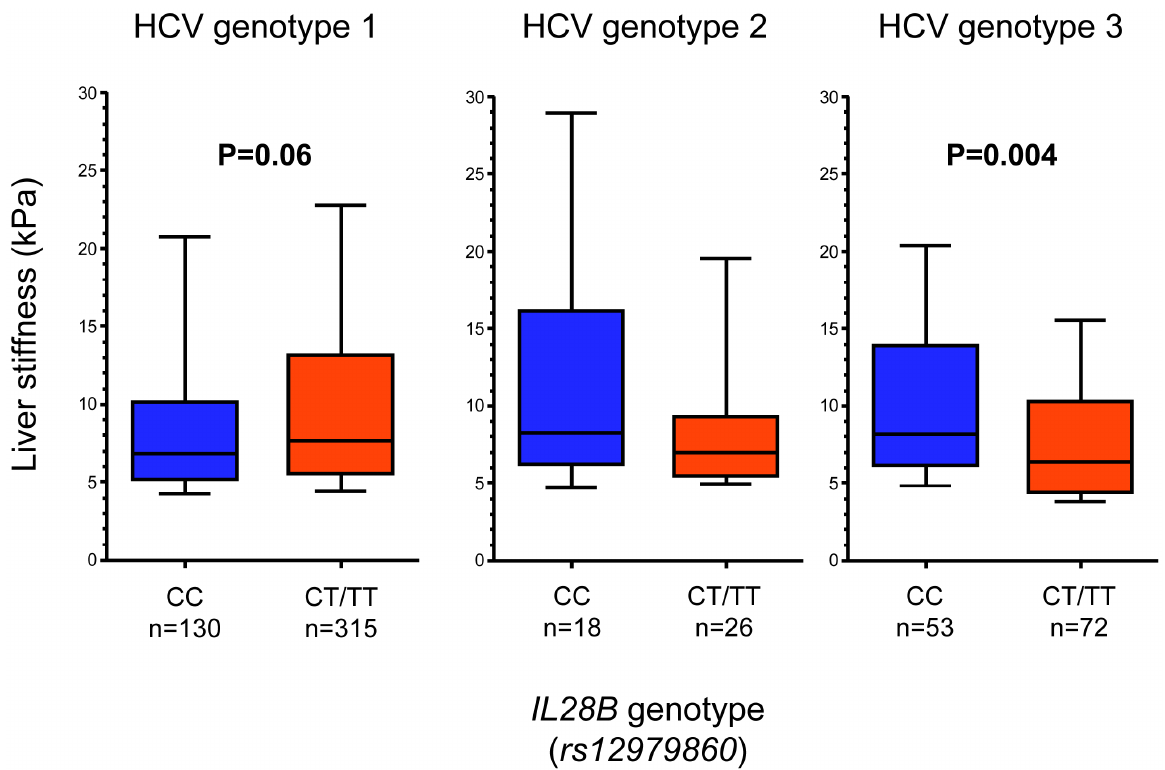
Figure 3. Tenth, 25 th , 50 th , 75 th , and 90 th percentiles of liver stiffness measurement level in relation to IL28B variants for genotypes 1, 2 and 3.